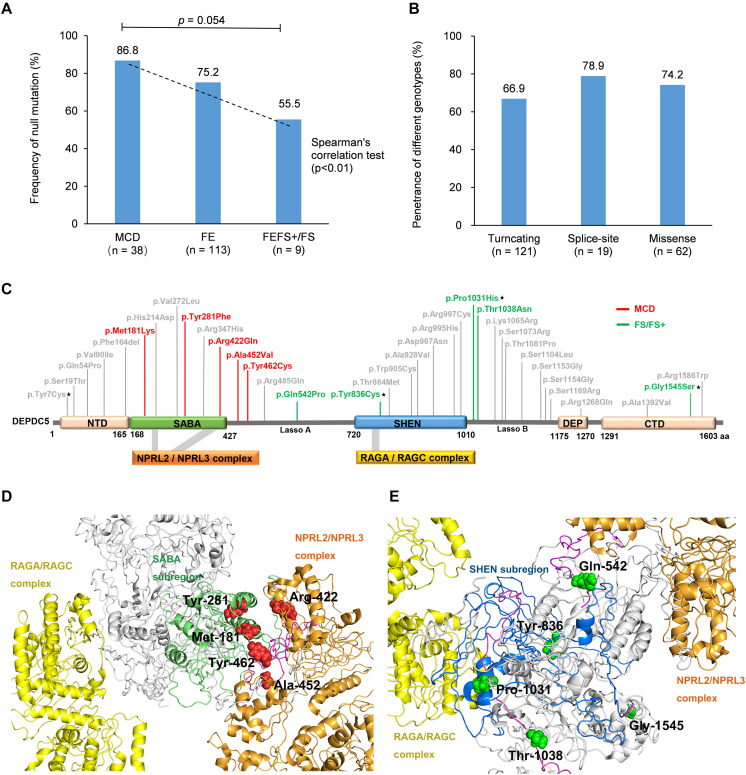
Genotype–phenotype correlations of DEPDC5 mutations. (A) The frequency of null mutations in DEPDC5 for each phenotype. The values are expressed as the percentage of cases with null mutations (cases with null mutations/total cases) in each group. (B) The penetrance of different genotypes of DEPDC5 mutations. Chi-square test or Fisher’s exact test was used for statistical analysis of the differences. Spearman’s correlation test was used for correlation analysis. (C) Schematic diagram of DEPDC5 domain and position of the missense mutations. Malformation of cortical development (MCD) and focal epilepsy with febrile seizures plus/febrile seizures (FEFS+/FS) associated mutations were colored red and green, respectively. The mutations reported in this study are indicated by black stars; the others were from literature. (D,E) The spatial location of MCD and FEFS+/FS associated mutations in 3D protein structure. The colors indicated in D,E for domains are the same as those in (C).